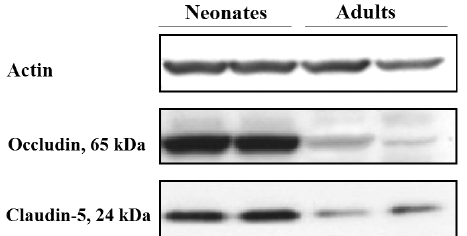
Fig. 7. The immunohistochemistry study of expression of claudin-5 (brown color) in cerebral veins (arrowed) in newborn (on the left) and adult (on the right)